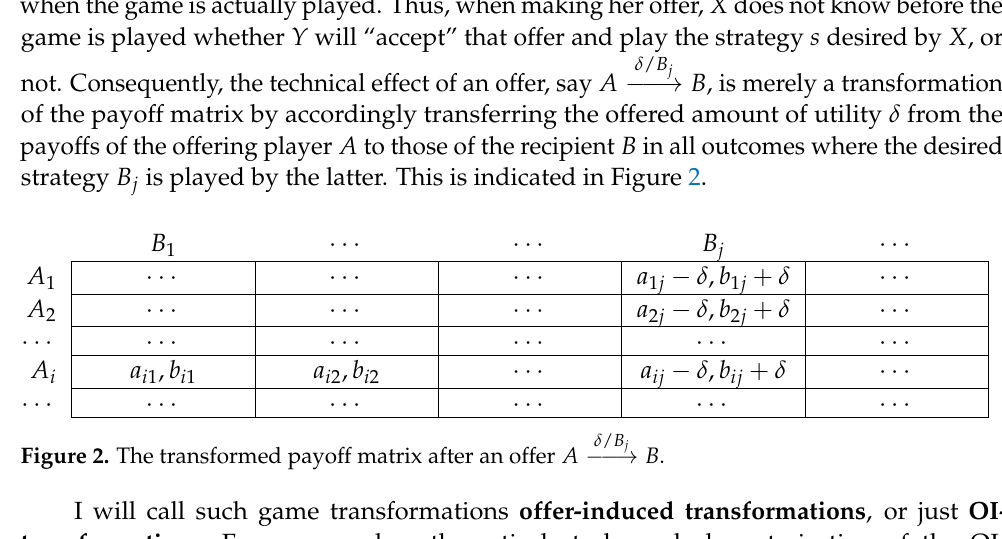
Figure 3. Prisoner’s Dilemma